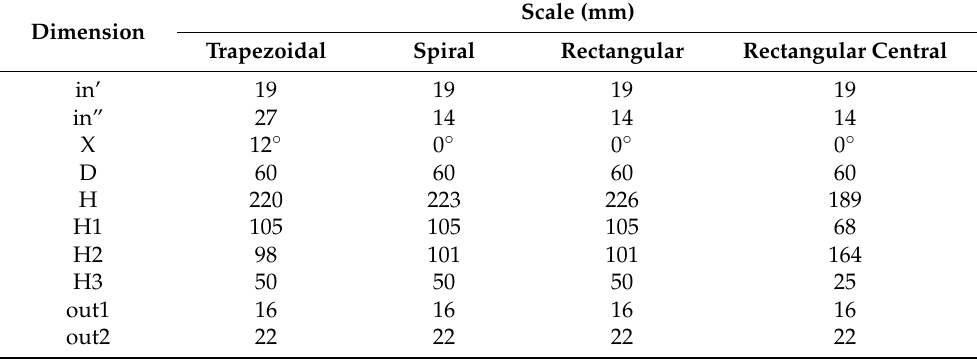
Figure 1. Structure diagram of cyclone. Table 1. Geometry of the cyclone.